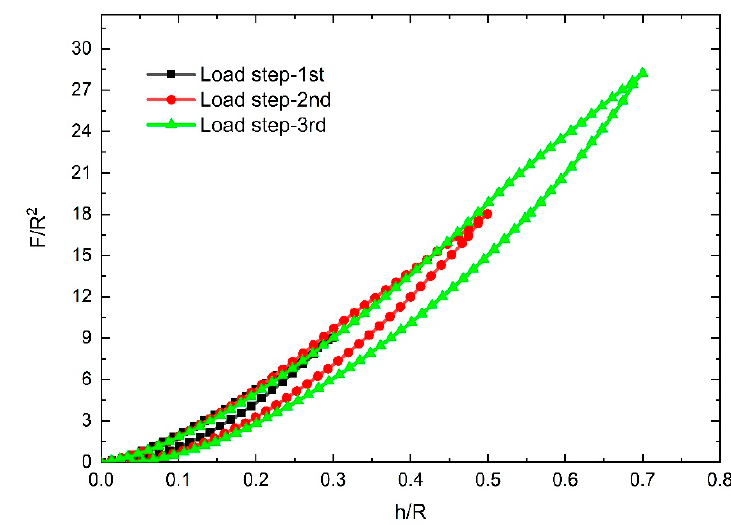
Figure 3. Corrected test results for the unfilled polyurethanes (UFPUs) subjected to cyclic compressive loads.